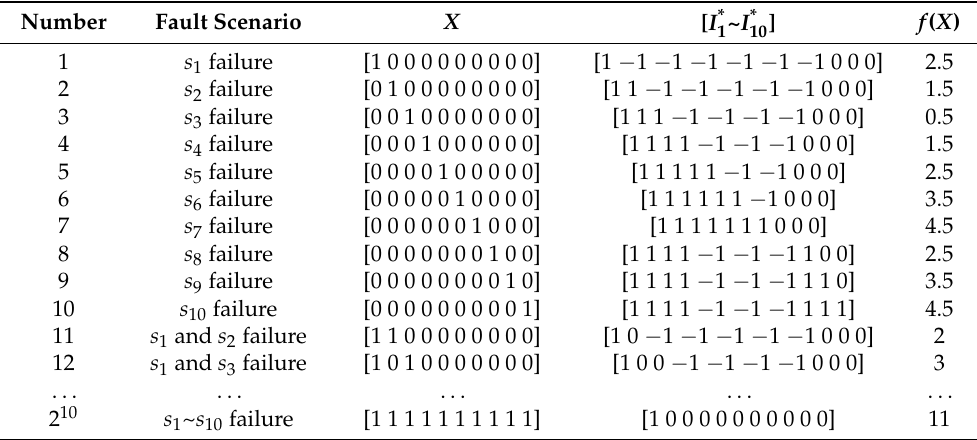
Table 1. Vector X and its switching function and objective